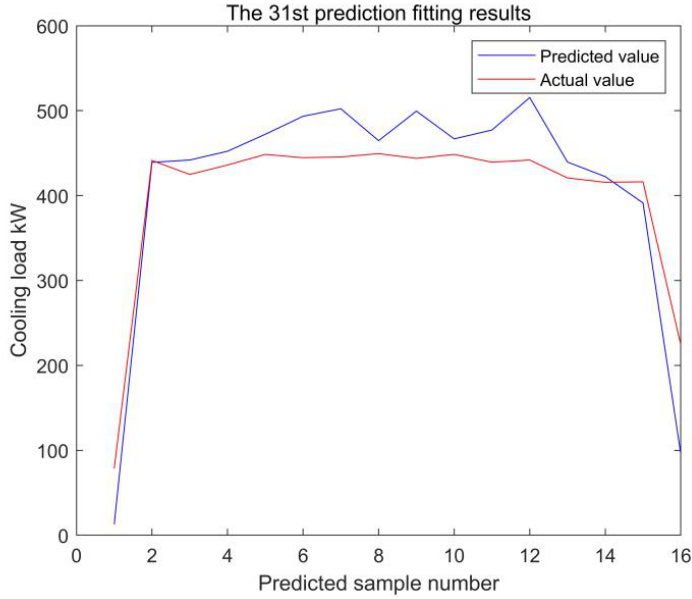
Figure 24. The fitting effect of the prediction set for day 31 predicted 1 h in advance.